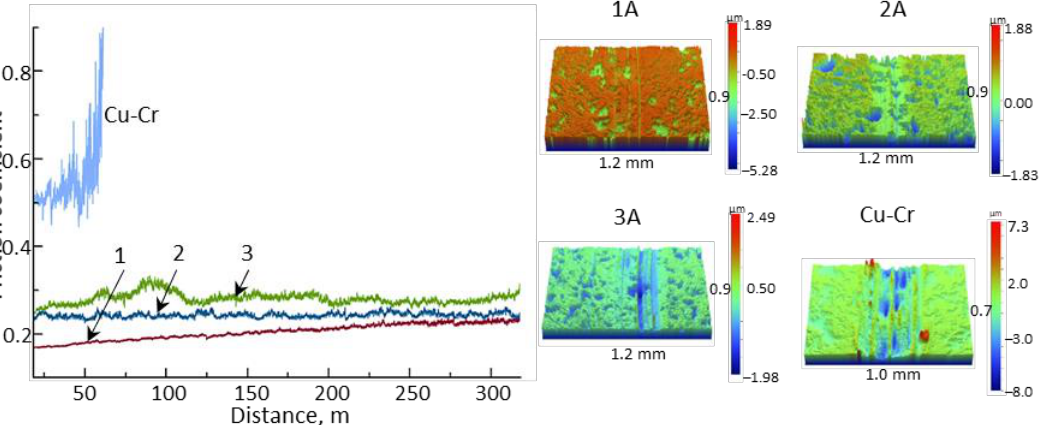
Figure 5. Dependence of the friction coefficient on the distance for coatings 1 – 3 and uncoated sub-